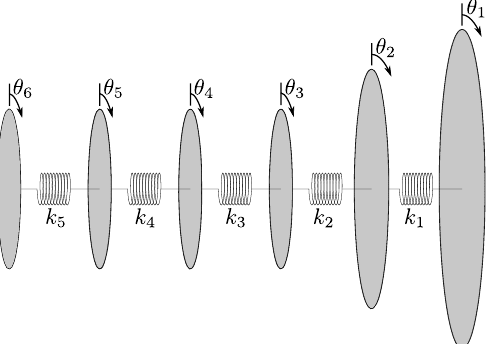
at each operating point using (5), make up the inertia and stiffness matrices for the